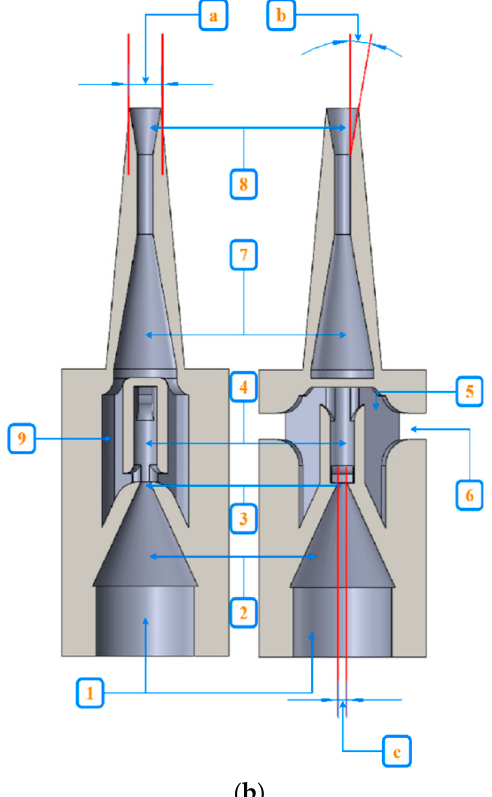
Figure 18. Schematic of the vacuum-generated seed suction nozzle. ( a ) VGSN structure view; ( b ) VGSN cross-section diagram. a. Diameter of the seed suction port, b. Suction port angle, c. Diameter of the spout. 1. air inlet (air pipe interface), 2. contraction section, 3. spout, 4. throat, 5. exhaust air- way, 6. exhaust port, 7. vacuum airway, 8. seed suction port, 9. vacuum chamber.